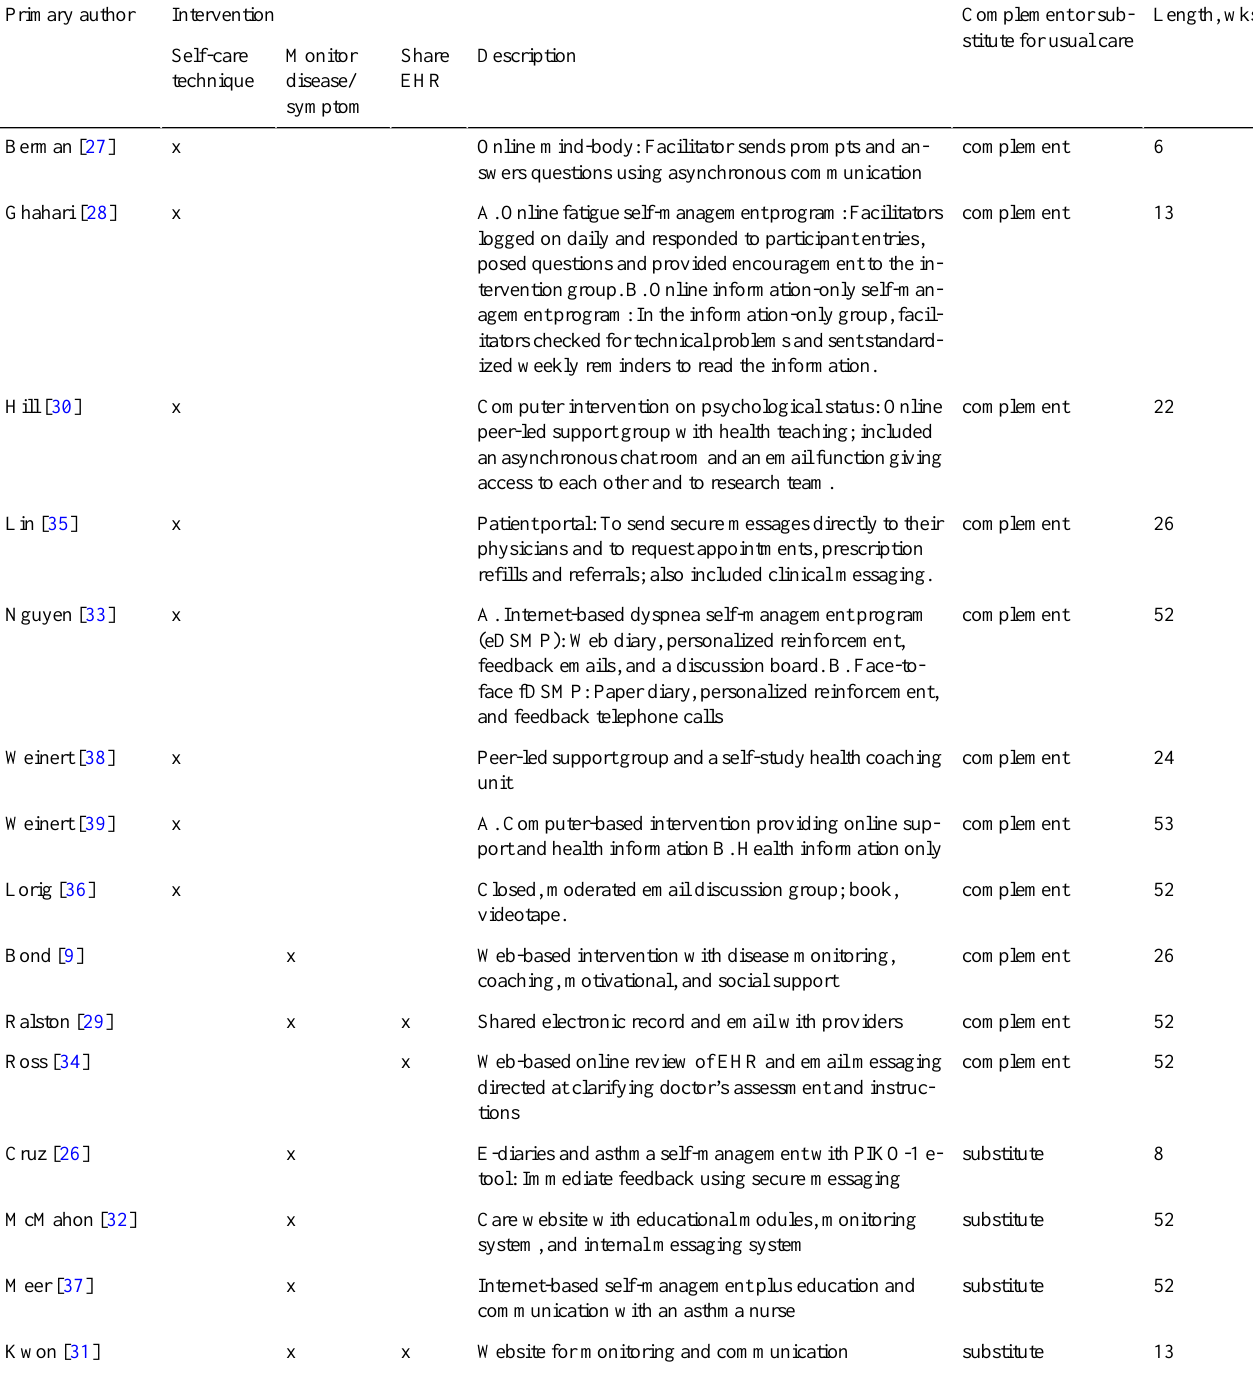
Table 2. Characteristics of the